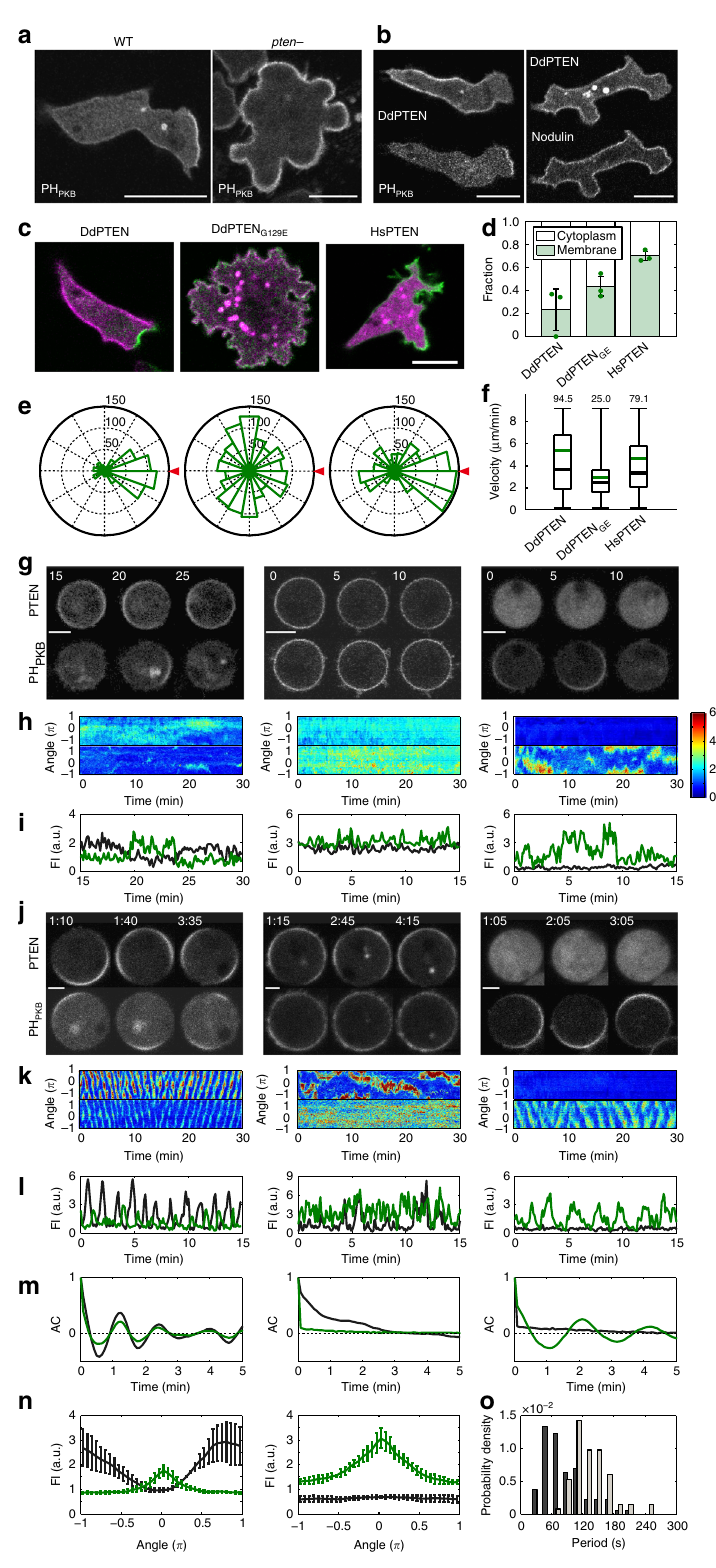
broadened and prolonged manner (Fig. 1g – i, right), and HsPTEN remained in the cytoplasm without any detectable membrane localization irrespective of PIP3 levels. For the purpose of statistically comparing the spatiotemporal characteristics of the PIP3-enriched domains, all cells were further treated with 4 mM